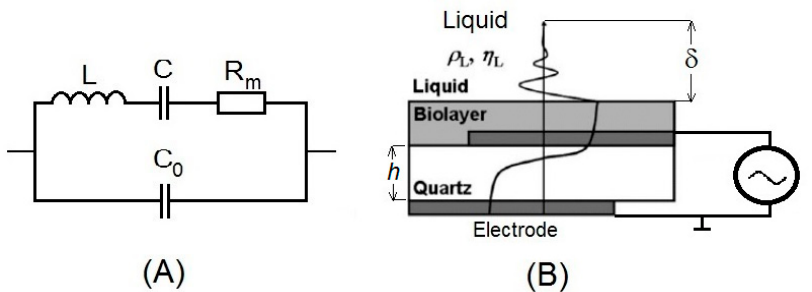
Figure 3. ( A ) Butterworth-van-Dyke (BvD) equivalent circuit. C 0 = ε A/h is the parallel electrical capacitance, L = 1/ ω 2 C is the motional inductance (proportional to the mass), C = 8K 2 C 0 /(N π ) 2 is the motional capacitance (inversely proportional to the stiffness) and R m = η q / μ q C is the motional resistance related to the dissipative losses. A is the electrode area, ε and h are the dielectric permittivity and thickness of the crystal, respectively, ω = 2 π f, where f is series resonant frequency , K is the electromechanical coupling coefficient and N is the integer. η q is the effective viscosity, and μ q is the shear stiffness . ( B ) Scheme of the propagation of the acoustic wave. η L and ρ L are the viscosity and density of the liquid, respectively. δ is the penetration depth.